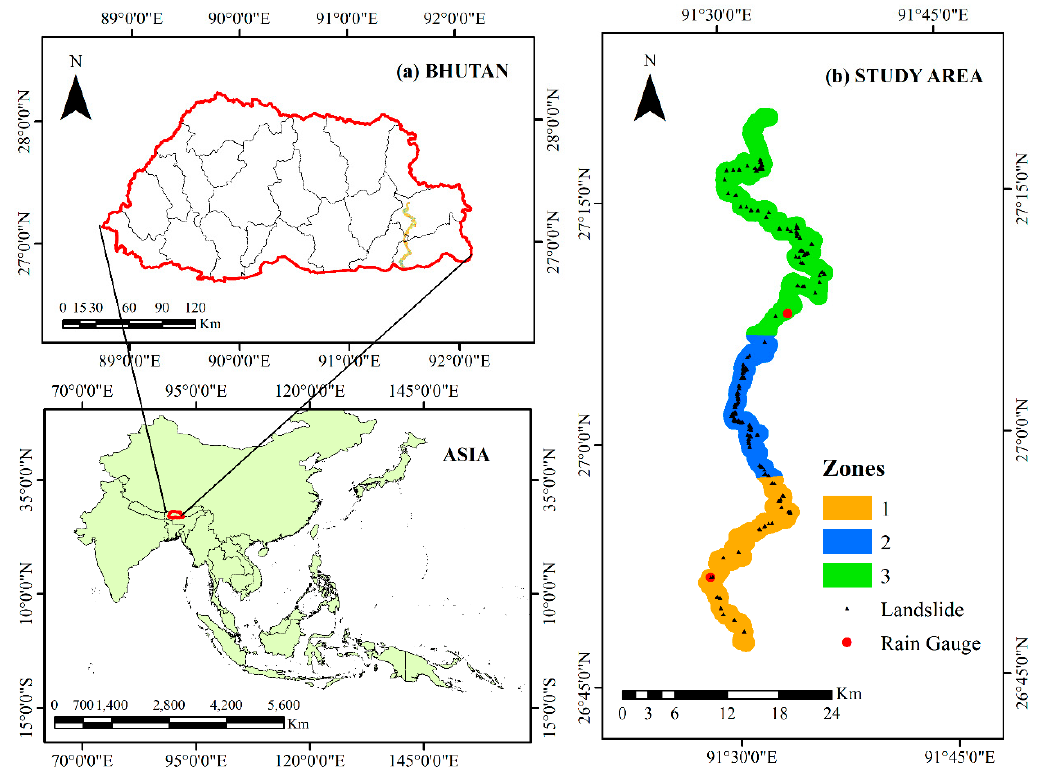
Figure 1. Location of ( a ) Bhutan; ( b ) spatial distribution of landslides in the study area considered in this analysis. The zones were categorized based on spatial coverage of rain gauges, rain gauge location, and elevation difference.